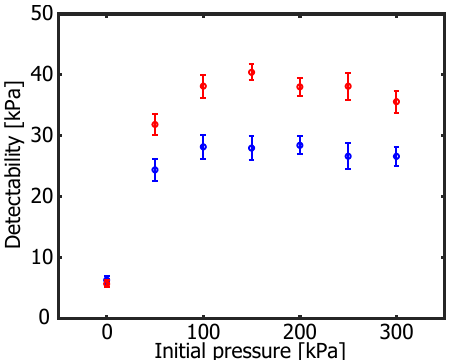
Figure 9. Detectability index calculated from the sample data. Blue and red colors mean values of the RCB and LCB PARMs. Markers are average values, and thin bars are standard